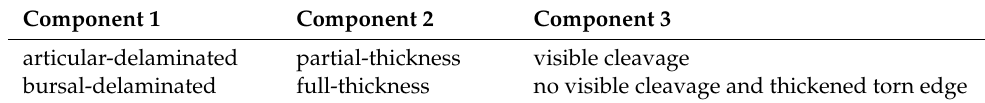
Table 4. Three components of delaminated tears on preoperative MRI.